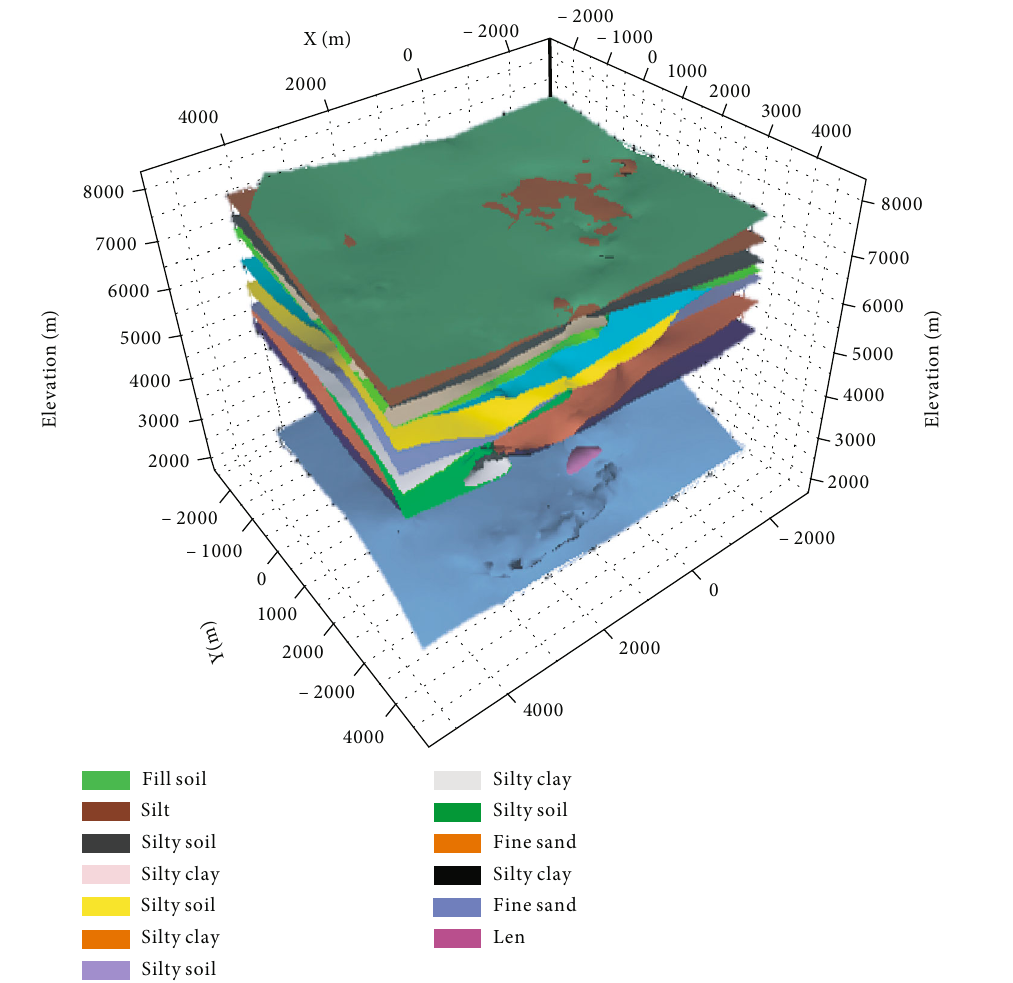
Figure 6: Stratum layer